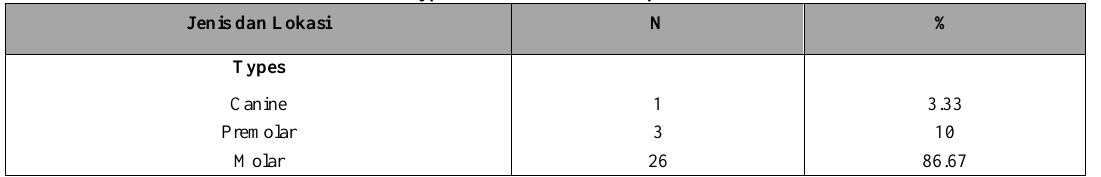
Table 2. Type and Location of the impacted